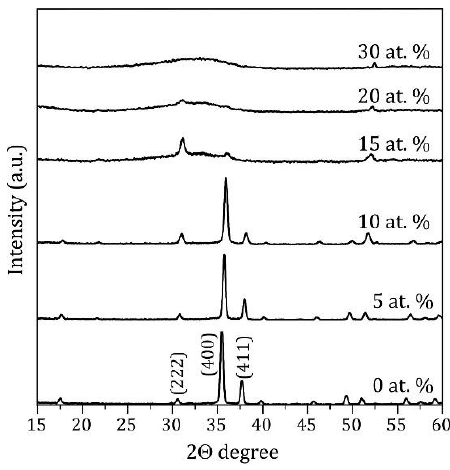
Figure 1. ( a – d ). SEM images of ITO:Ga films with 0, 5, 10 and 15 at.% Ga.